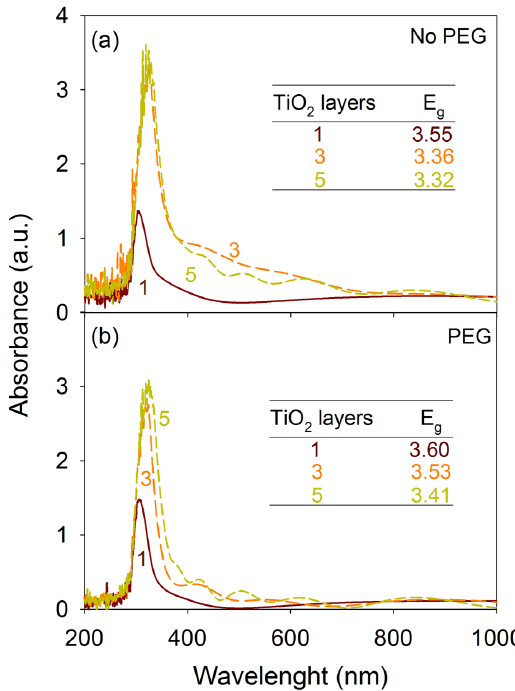
Figure 6. UV‑Vis absorption spectra for the TiO number of layers: (a) no PEG, (b) with PEG. The E for the TiO films are indicated in each figure. 2